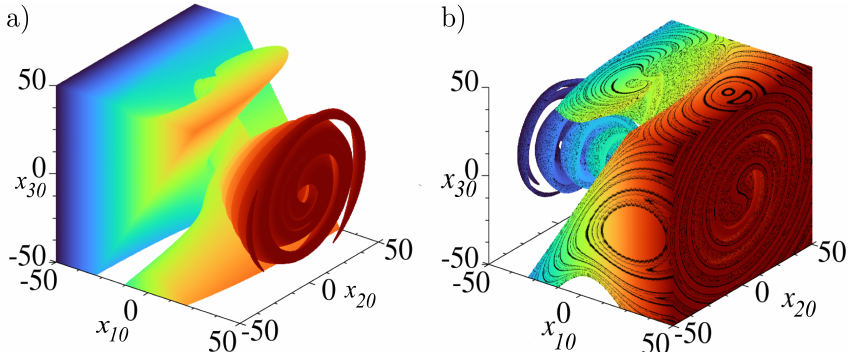
Figure 4. Three-dimensional basin of attraction on a grid of 120 × 120 × 120 points. In ( a ), we plotted the basin of attraction of the red attractor of Figure 3b. In ( b ), the colored region is the basin of the blue attractor of Figure 3b, while the black region is the basin of the black